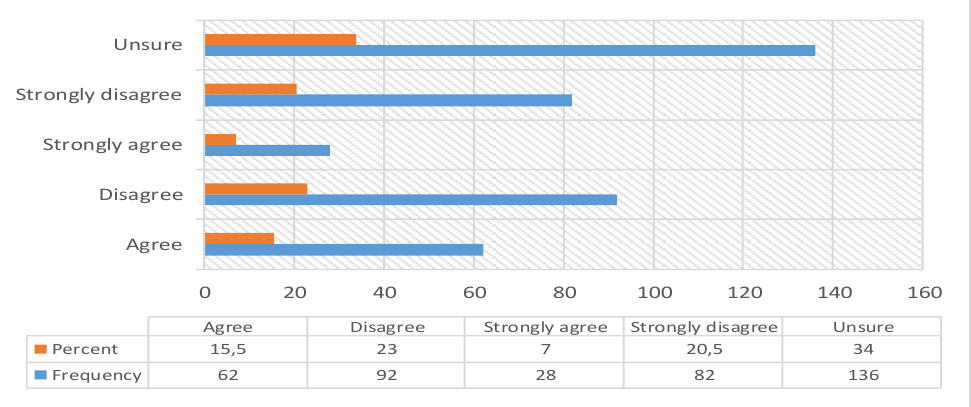
Figure 7: Implementation of IDP development projects; Source :